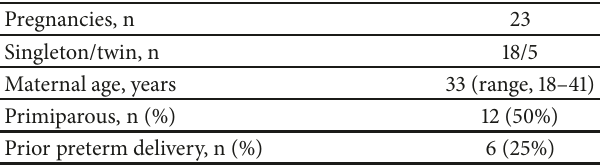
Table 1: Baseline maternal characteristics.